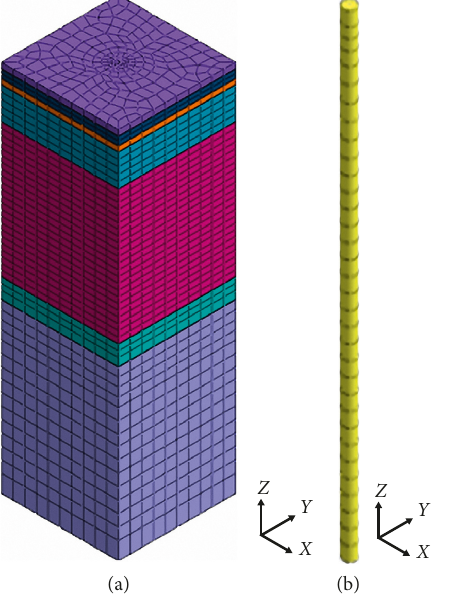
Figure 7: Finite element model of pile-soil interaction: (a) overall model; (b) pile